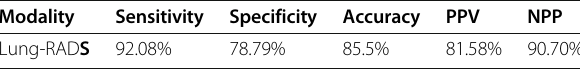
Table 6 Sensitivity, specificity, and accuracy of lung-RADS for all studied lesions Modality Sensitivity